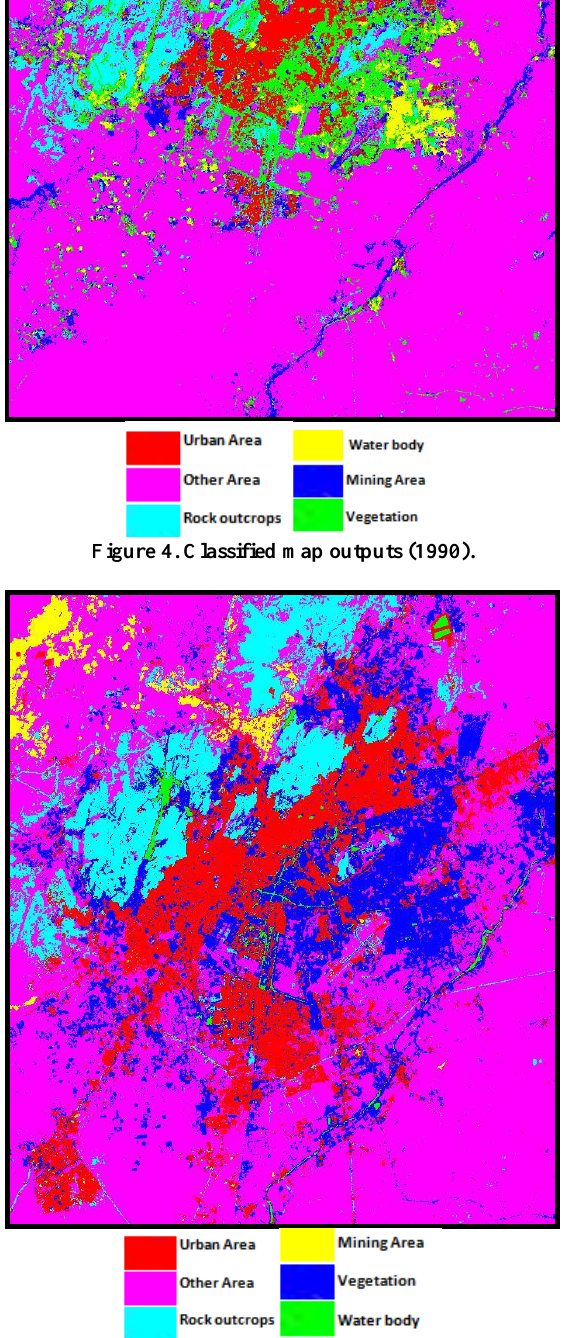
Figure 5. Classified map outputs